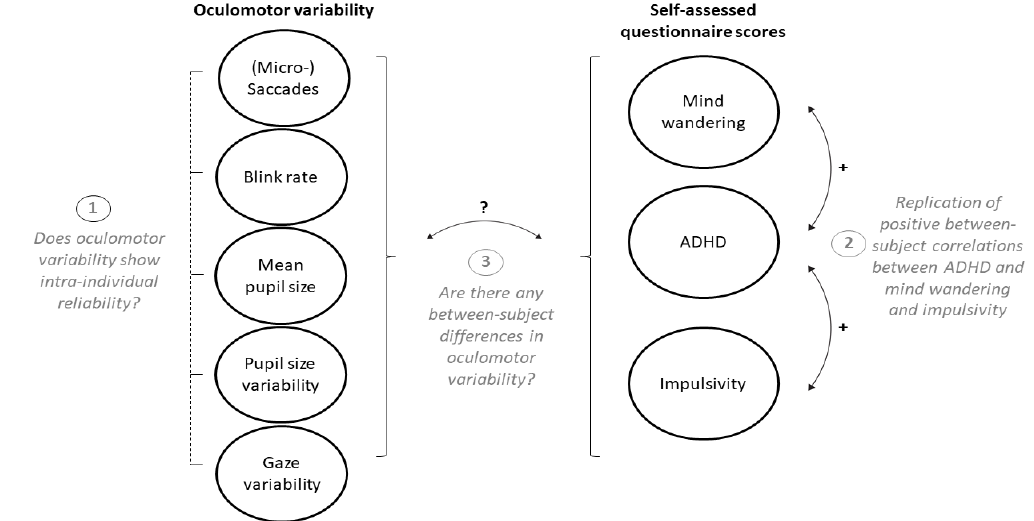
Figure 1. Graphical representation of the oculomotor measures and self-assessed questionnaire scores, with the three aims of the current